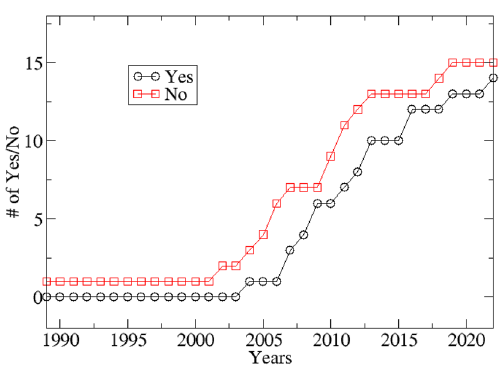
Figure 3. Cumulative number of acceptance of the correlation hypothesis (yes) and rejection (no) of the correlation hypothesis over the